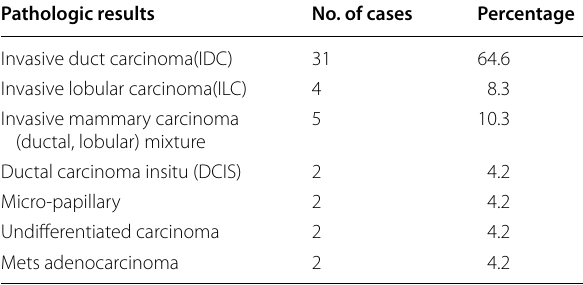
Table 1 Malignant breast lesions associated with edema